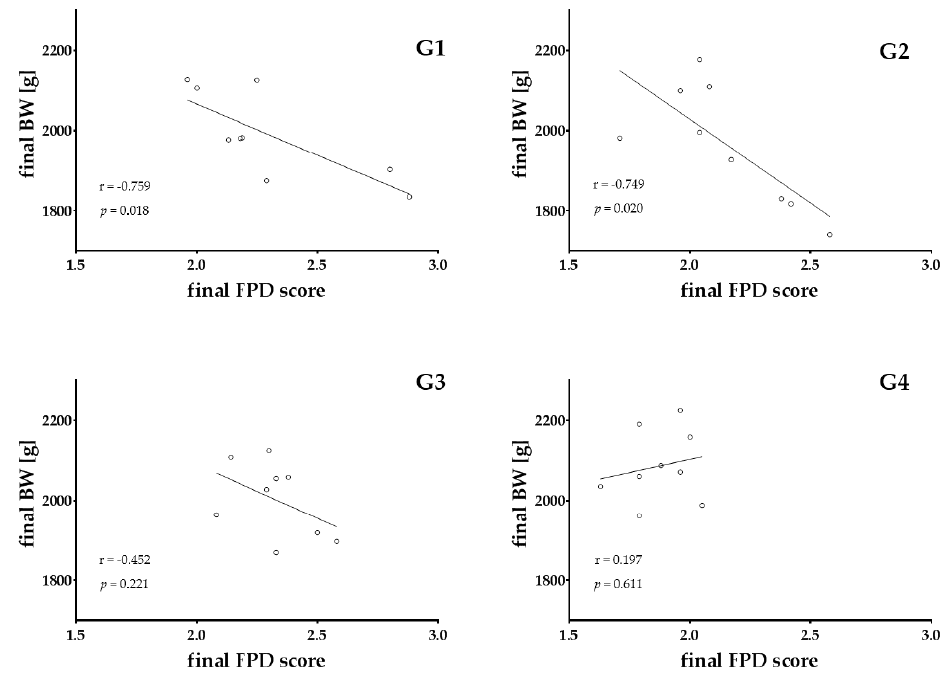
Figure 3. Spearman’s rank correlation coefficients with significance levels between the final body weight and final FPD-scores in the turkey experiments are displayed ( p < 0.05). G1 = entire floor pen covered with litter; G2 = floor pen covered with litter and having floor heating; G3 = partially (50:50)-slatted flooring including an area with litter; G4 = fully-slatted flooring with a sand bath (900 cm 2 ). Table 5. Prevalence of foot pad dermatitis (%) in broiler chickens and turkeys kept on different types of flooring at the end of the experiment.